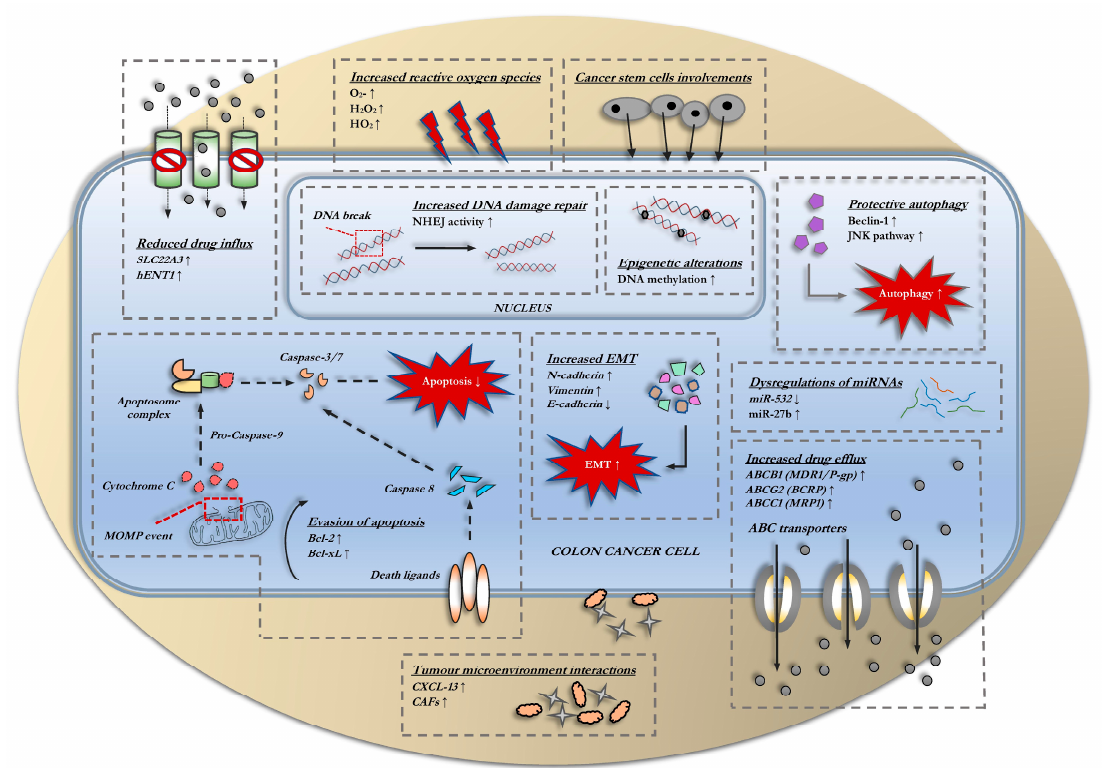
Figure 2. Recent discoveries on the classical drug resistance mechanisms involving 5-FU resistance in colon cancer